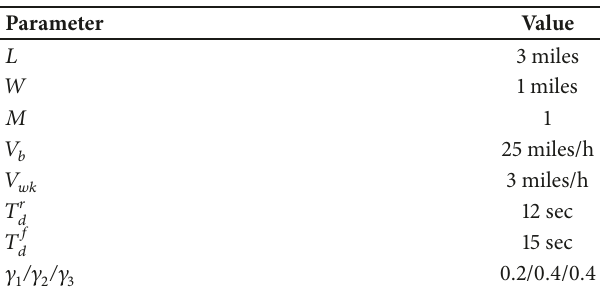
Table 1: Parameter